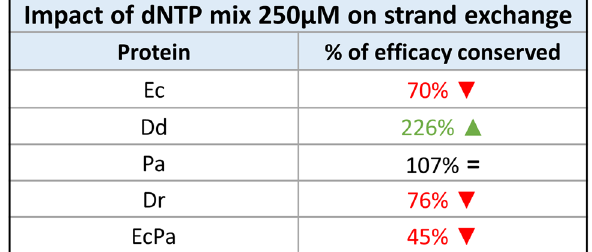
Figure 9. Impact of the addition of the dNTP mixture on the strand exchange reaction catalyzed by RecA variants. The strand exchange efficiency was evaluated for each RecA variant in the presence of a mixture of dNTPs at 250 µM each. Each protein was used under the best conditions determined, except the EcRecAV1 and EcRecAV2 variants, which were not included in this study. The dNTPs were added in the final step of strand exchange, and the efficiency of the reaction was evaluated by calculating the percentage of fluorescence corresponding to NCP compared to the total fluorescence (of NCP plus linear dsDNA; ssDNA and joint molecules were excluded).